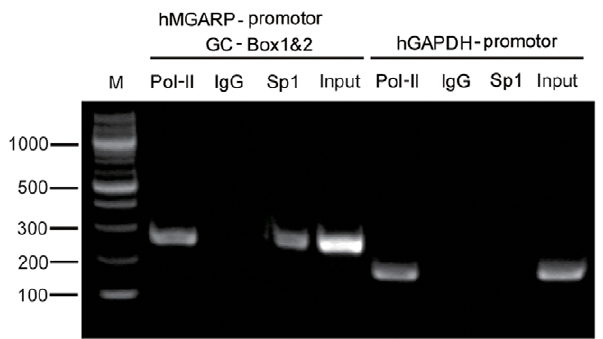
Figure 5. ChIP analysis indicates that Sp1 binds to MGARP promoter invivo . ChIP was performed as described in the Materials and Methods. HEK-293T cells and antibodies for RNA polymerase II (Pol II) and Sp1 were used, with IgG as control. The immunoprecipitated chromatin was amplified by PCR with primers specific for the GC-rich region (BOX1&2) of the MGARP promoter ( 2 3 kb), with GAPDH locus as control. M: DNA Marker.